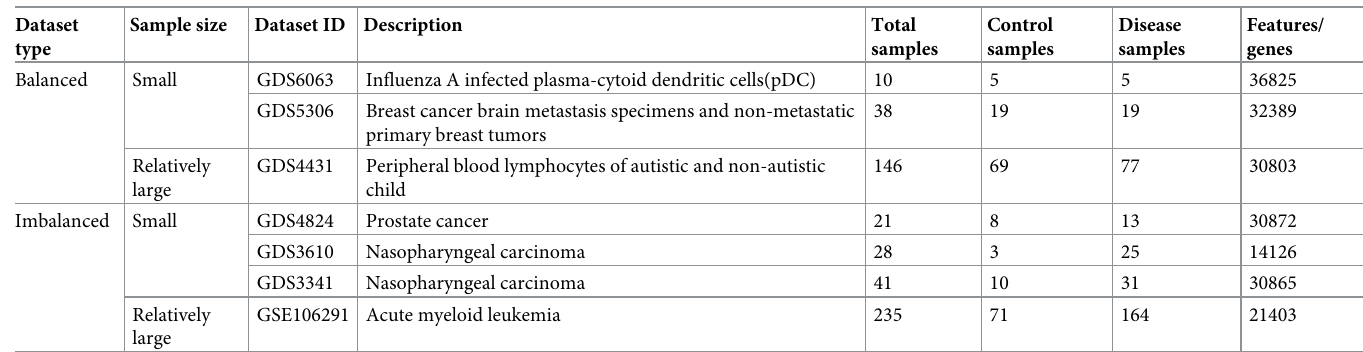
Table 1. Summary of the datasets used in this